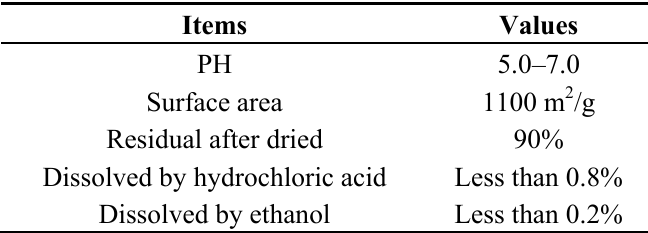
Table 1. Basic characteristics of active carbon.